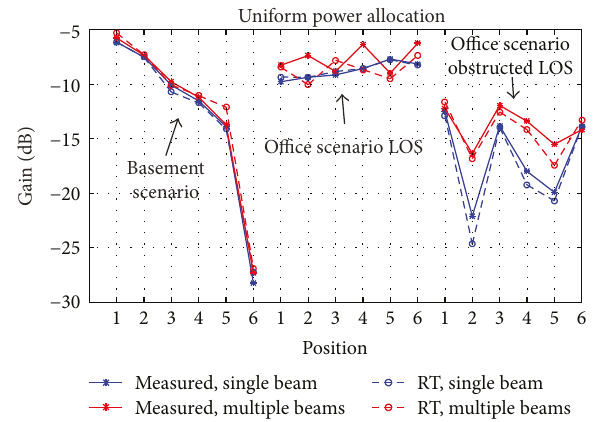
Figure 26: The target and achieved channel gains with the RT- assisted beamforming techniques with the uniform power allocation